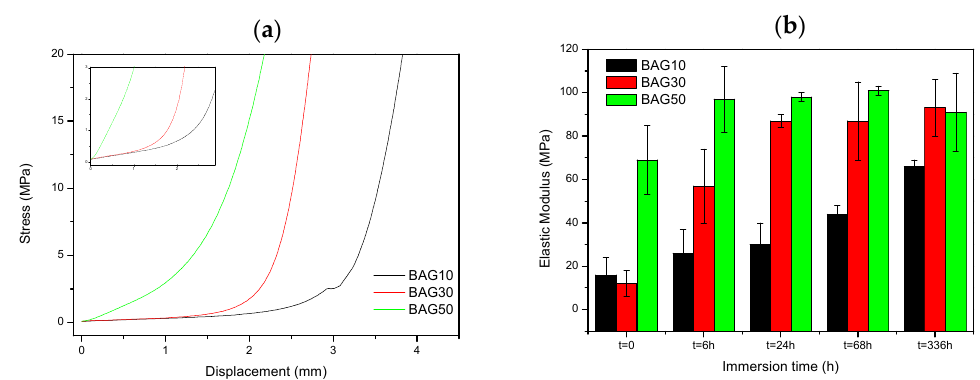
Figure 7. Typical compression test curves ( a ) and Young’s modulus of the composites as a function of immersion time ( b ). The insert in Figure 7a aims to show the initial linear relationships between stress and strain, where the Young’s modulus was quantified.